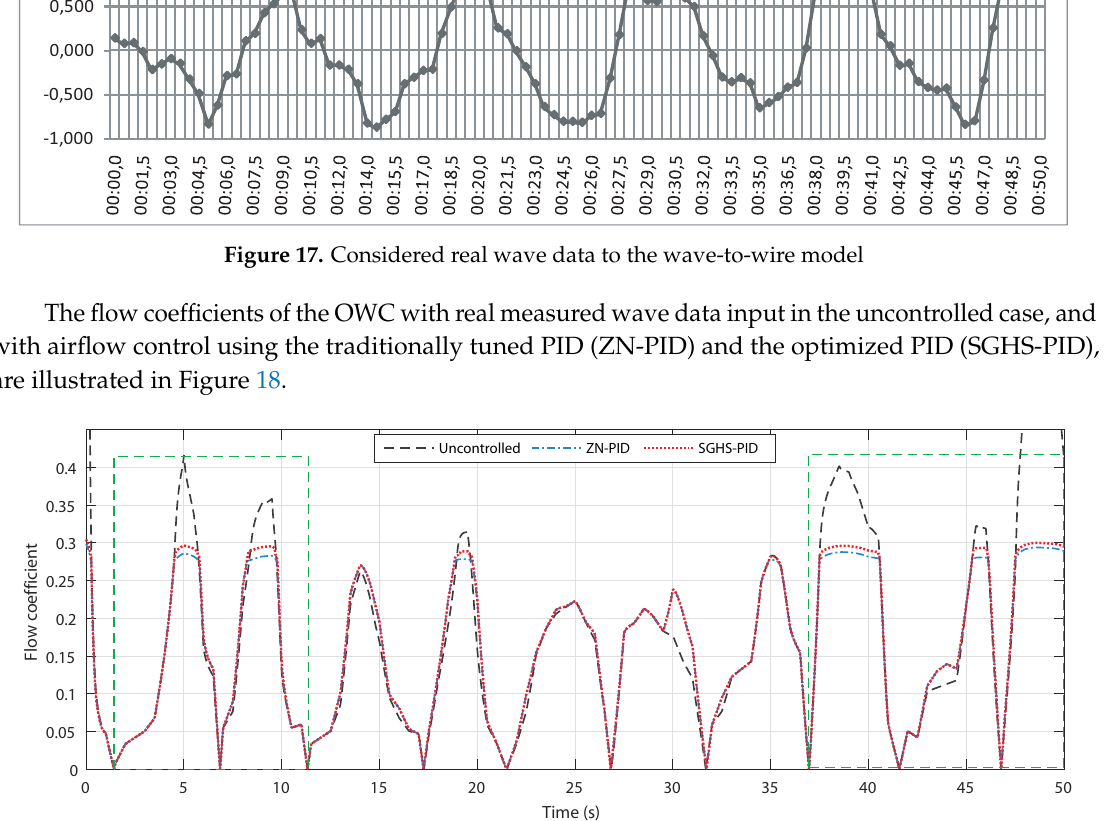
Figure 18. Flow coefficients of the OWC in uncontrolled and controlled